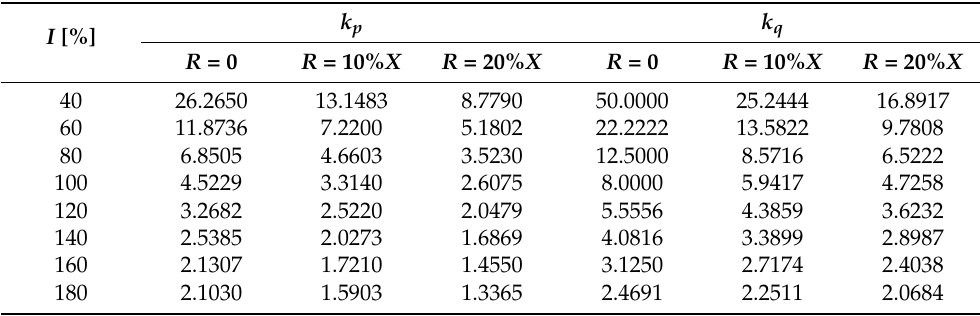
Table 2. Summary of the inclination coefficients of the power–voltage characteristics for various resistances of the circuit supplying the